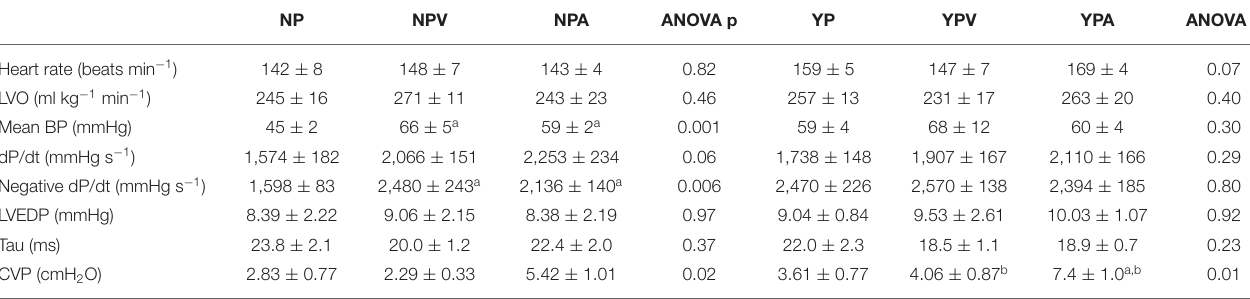
TABLE 1 | Group comparisons before intervention and the tachycardia protocol. NP NPV ANOVA